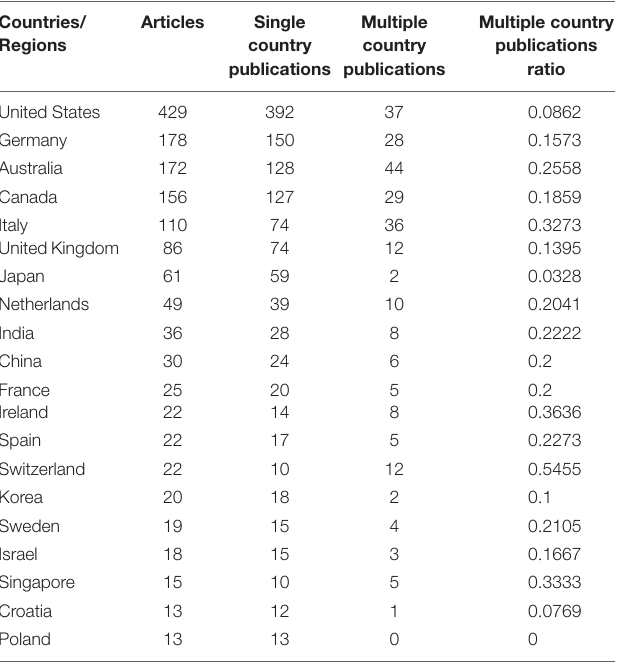
TABLE 8 | Correlation analysis between country or region-specific characteristics and bibliometric indices of psycho-oncology research. Variables Bibliometric Index